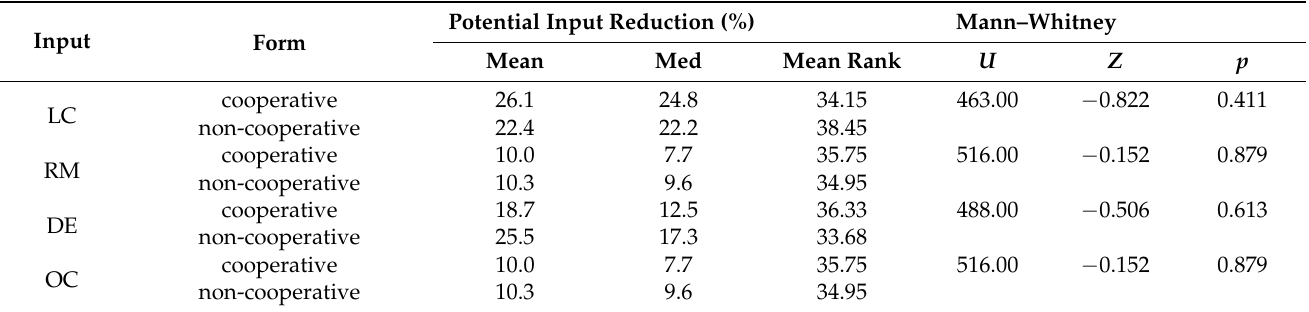
Table 7. Potential input reduction in inefficient dairies by legal form (authors’ calculations based on [77]).